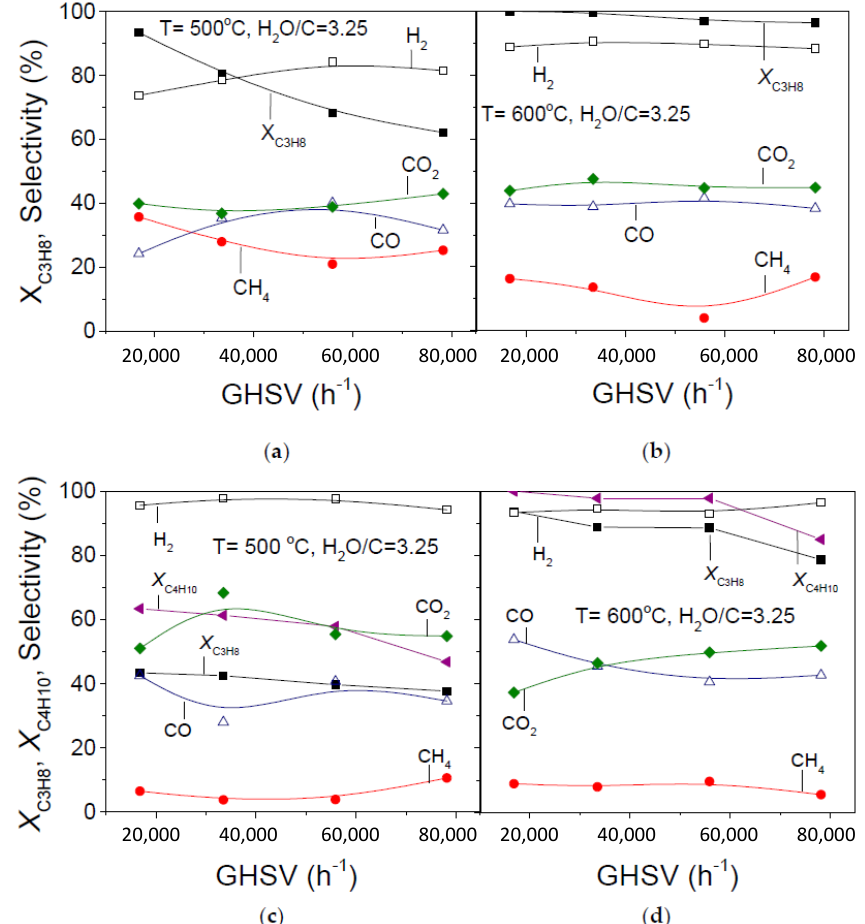
Figure 8. Effect of GHSV on ( a , b ) the conversion of C 3 H 8 and selectivities toward reaction products obtained under conditions of C 3 H 8 steam reforming and ( c , d ) the conversion of propane, conversion of butane, and selectivities toward reaction products obtained under conditions of C 3 H 8 /C 4 H 10 steam reforming over 0.5%Rh/TiO 2 at 500 and 600 ◦